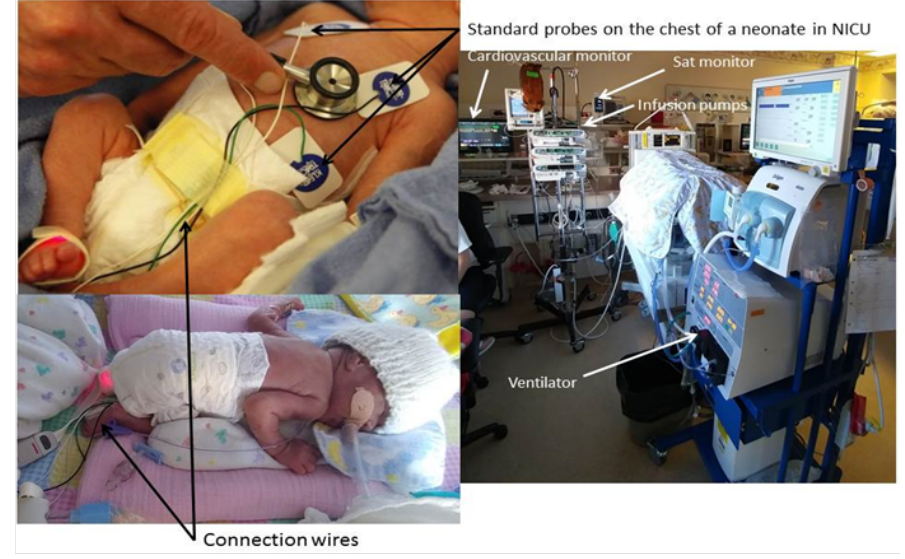
Figure 1. Standard monitors for a neonate inside a Neonatal Intensive Care Unit (NICU).